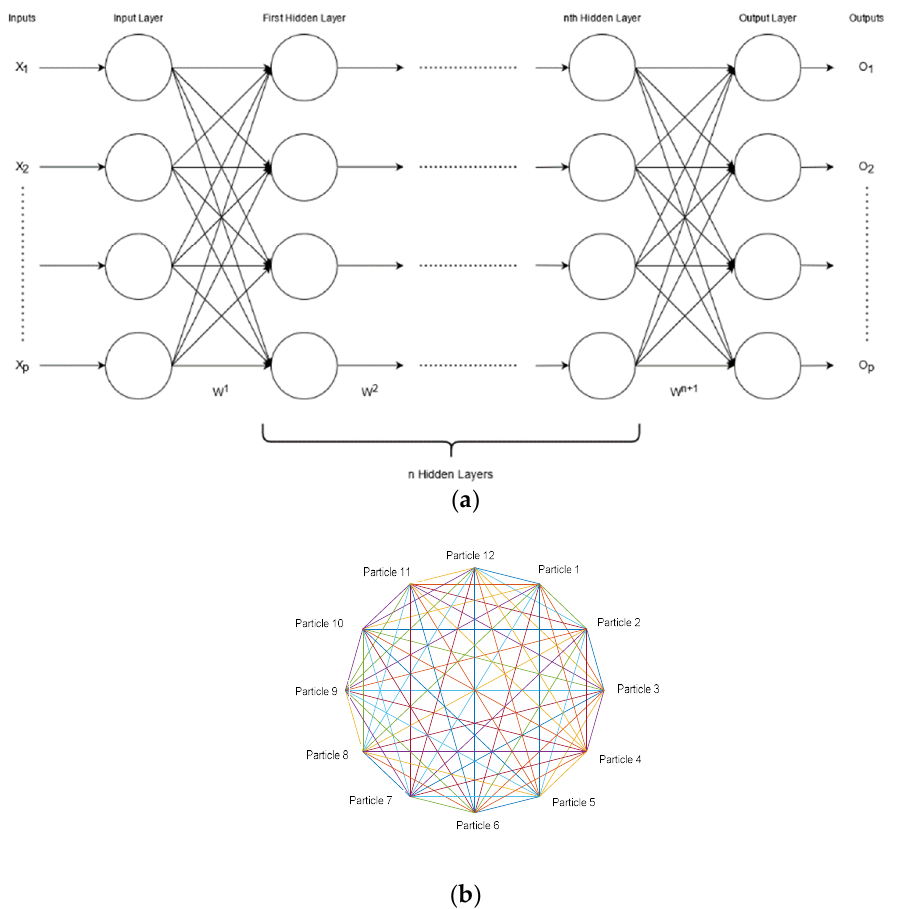
Figure 2. ( a ) A feed-forward neural network with n hidden layers, p input variables, and q output variables, with weights W; ( b ) fully connected topology [30] in PSO where each particle is connected to all other particles in the swarm (shown using 12 particles).